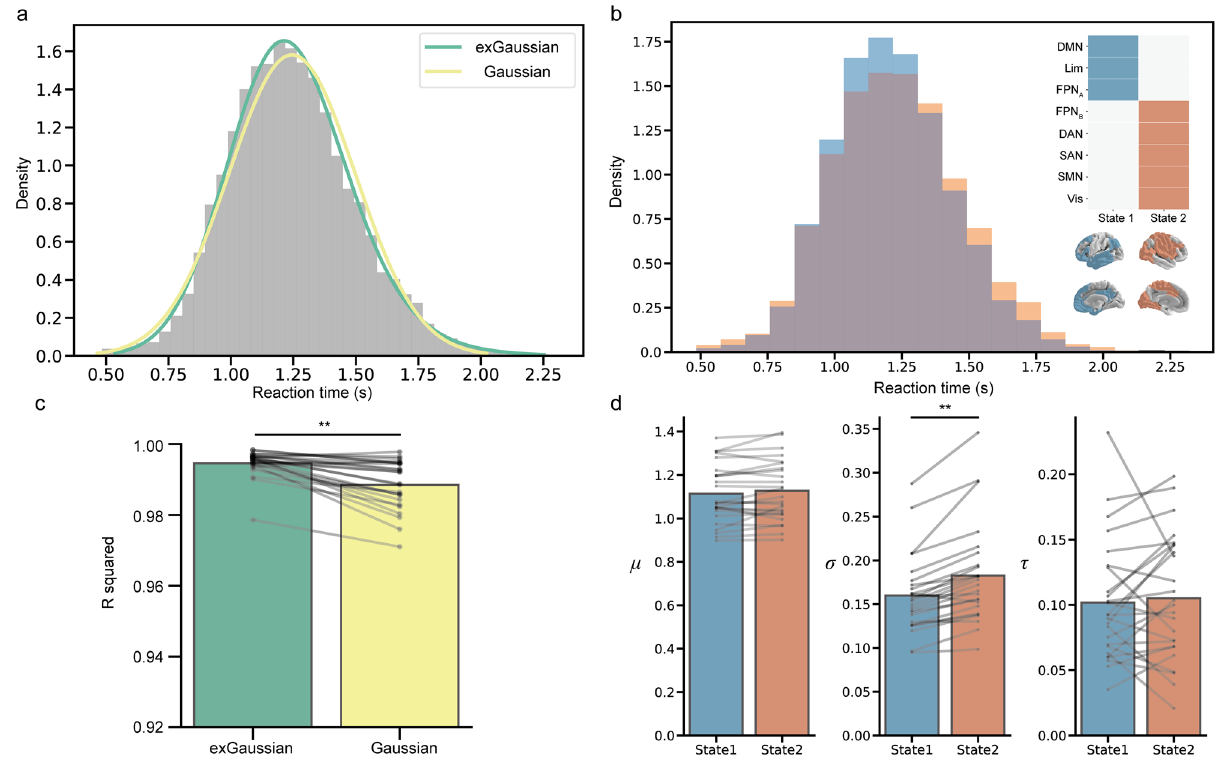
Figure 4. Results summary in Dataset3. ( a ) RT histogram and fitting result. ( b ) RT histograms in each brain state. Individual state is represented by an activity pattern in which each brain region is active (blue and red) or inactive (white). ( c ) R squared values for exGaussian and Gaussian distributions for each individual. ( d ) exGaussian parameters differences between brain states for each individual. ** p < 1.0 × 10 − 5 . DMN: default mode network; Lim: limbic; FPN: frontoparietal network; DAN: dorsal attention network; SAN: salience network; SMN: somatomotor network; Vis: visual.